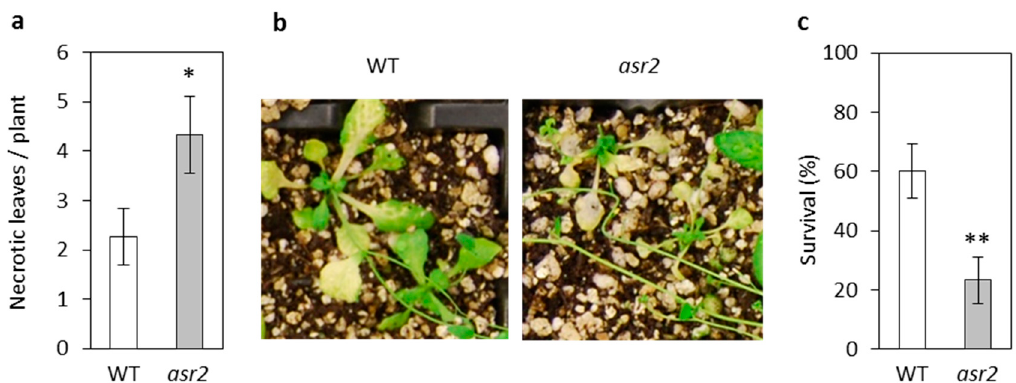
Figure 3. asr2 has increased susceptibility to the necrotrophic fungal pathogen Fusarium oxysporum . ( a – c ) Disease phenotypes of F . oxysporum inoculated plants with ( a ) necrotic leaves and ( b ) representative images of plants at 14 days post inoculation (dpi), and ( c ) survival of plants at 21 dpi. Values are averages ± SE ( n = 30). Asterisks indicate values that are significantly different (** p < 0.01, * p < 0.05 Student’s t -test) from wild-type (WT). Similar results were obtained in independent experiments.